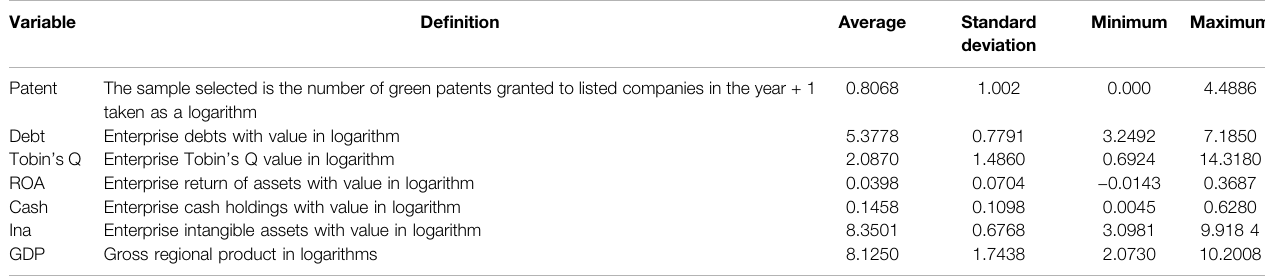
TABLE 2 | Descriptive analysis.